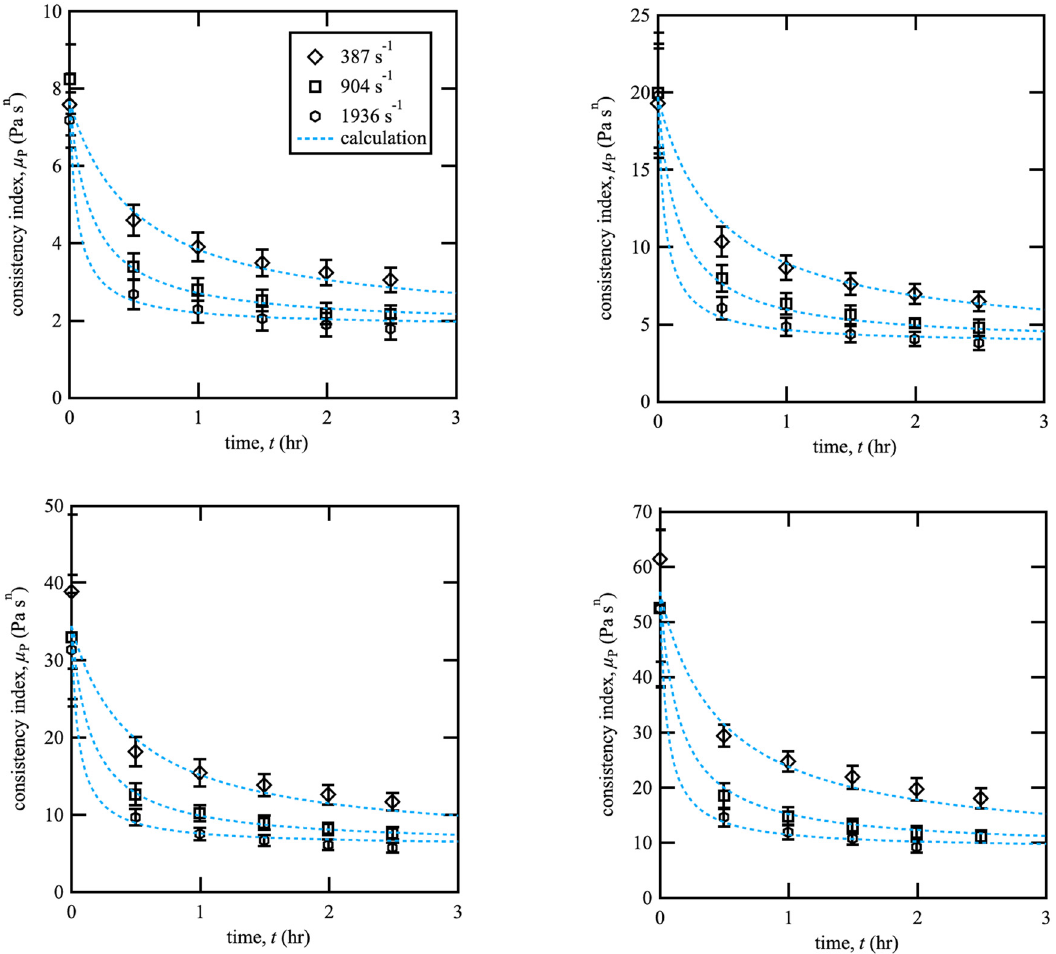
Figure 1: Change in μ P with shearing time, C = 42 g/L ( upper - left ) , C = 54 g/L ( upper - right ) , C = 63 g/L ( bottom - left ) , and C = 70 g/L ( bottom - right )